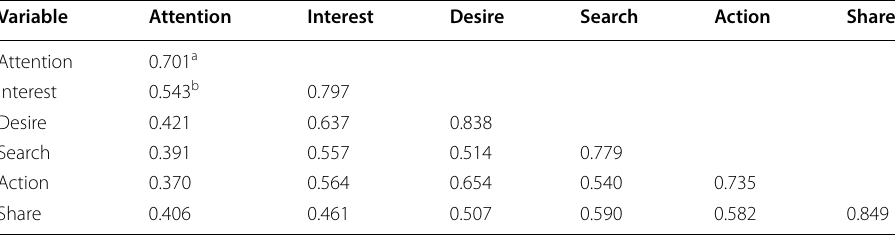
Table 3 Validity of measures: the squared correlation and AVE of variables